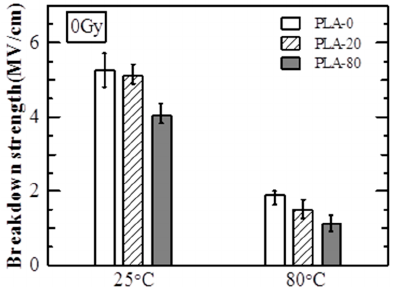
Figure 5. Breakdown strength ( E B ) of non ‐ irradiated samples (0 Gy).